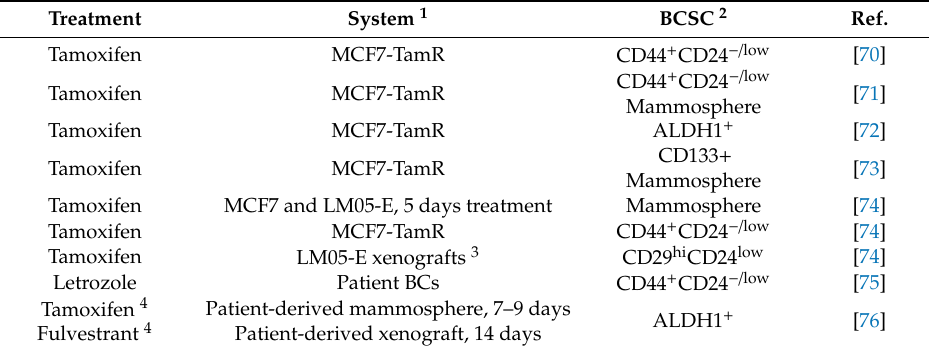
Table 1. Enrichment of BCSC following endocrine treatment.